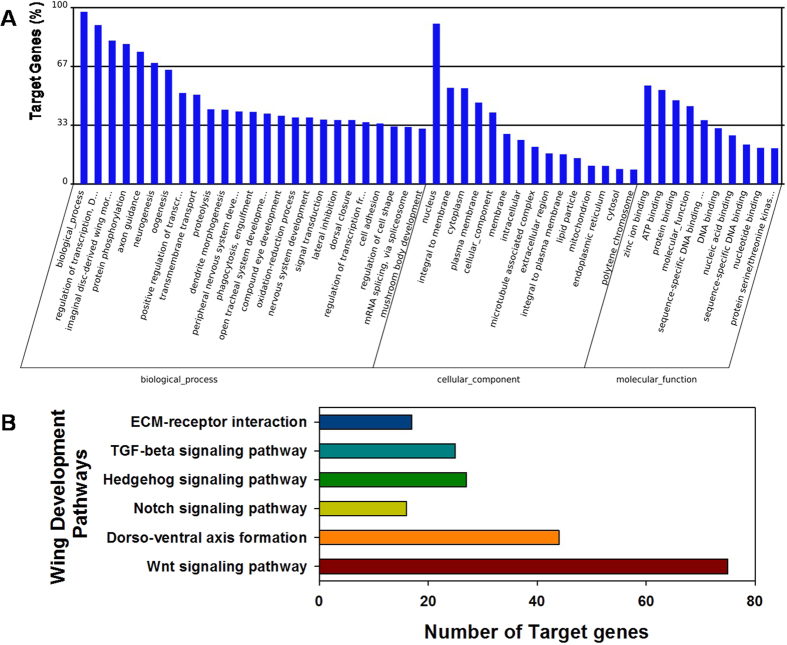
Histogram presentation of GO annoation and KEGG pathway for identified miRNAs in S. avenae.(A) Gene Ontology classification based on level two. The results are summarized in three main categories: biological process, cellular component and molecular function. The y-axis indicates the number of genes and its proportion in a category; (B) number of target genes joining wing development by KEGG analysis.